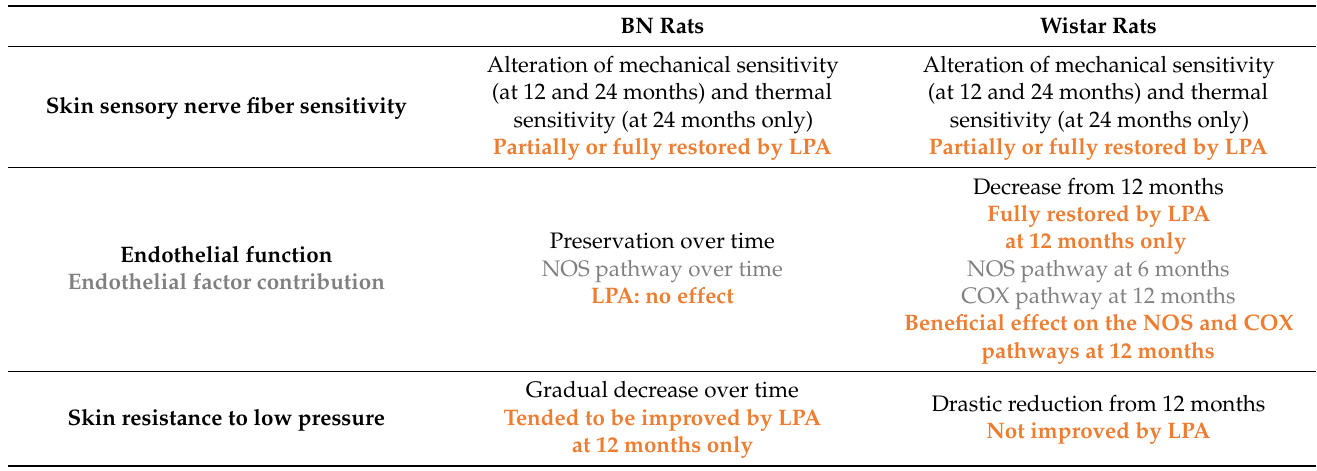
NOS pathway over time LPA: no